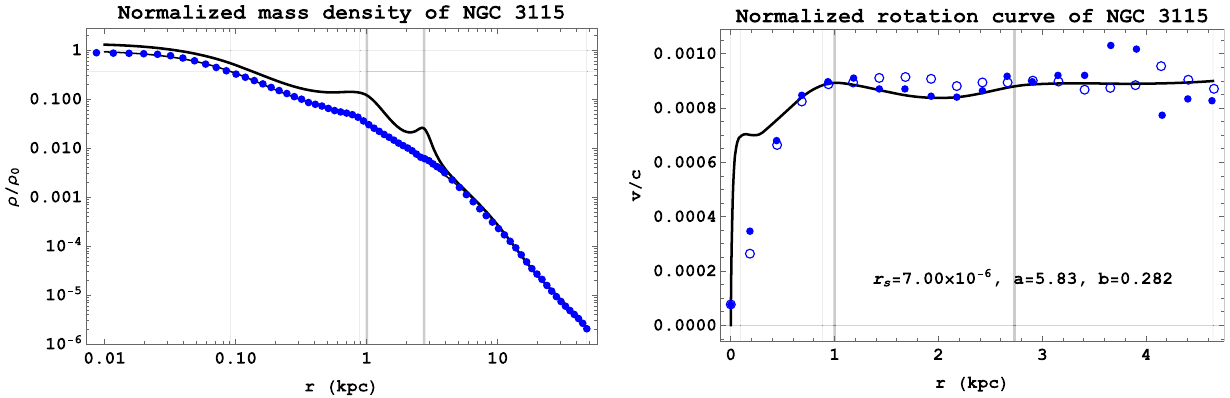
Fig. 12 This figure corresponds to the information introduced in Fig. 10, the only difference being a small increase in the Schwarzschild radius, from